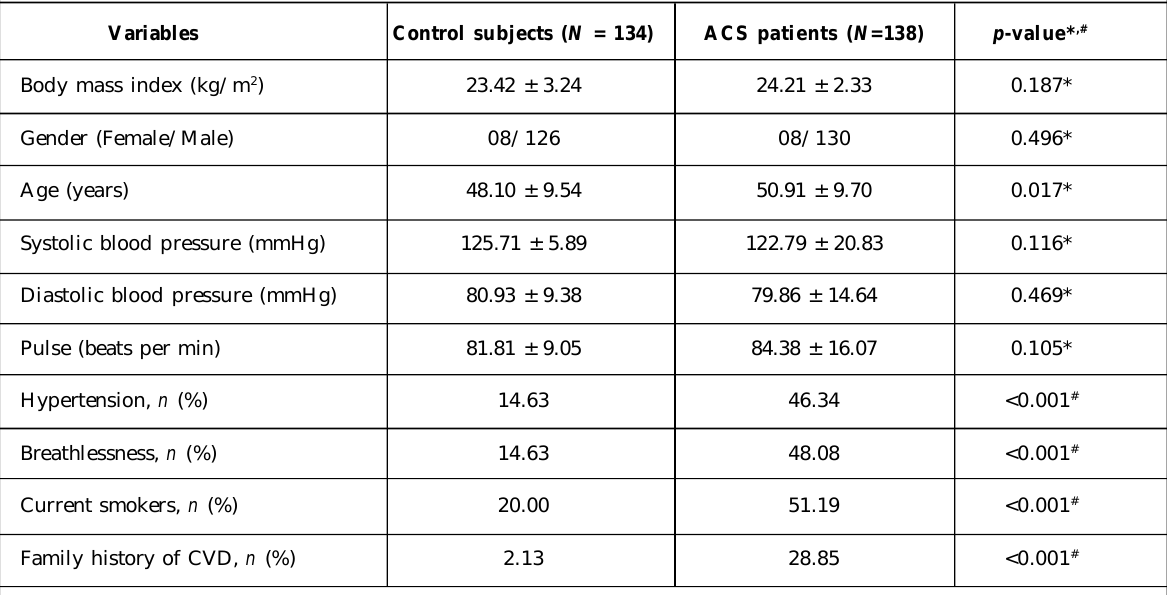
Table 1: Demographic and baseline characteristics of control subjects and ACS patients